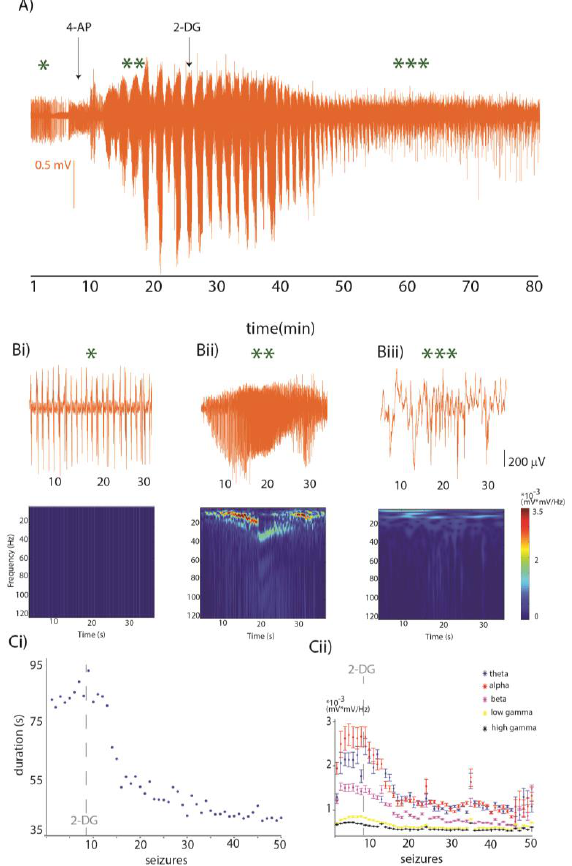
Figure 2. ( A ) Local Field potential recordings (orange) and extracellular potassium concentration (in purple); approximately 3 min following 4-Aminopyridine (4-AP) administration (arrow) recurrent seizures